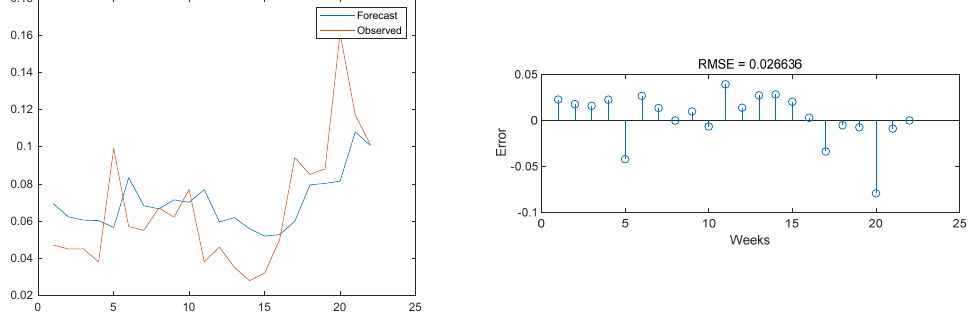
Figure 14. Prediction results of the ANN-LSTM model on the CODMn test set and comparison with the original image.